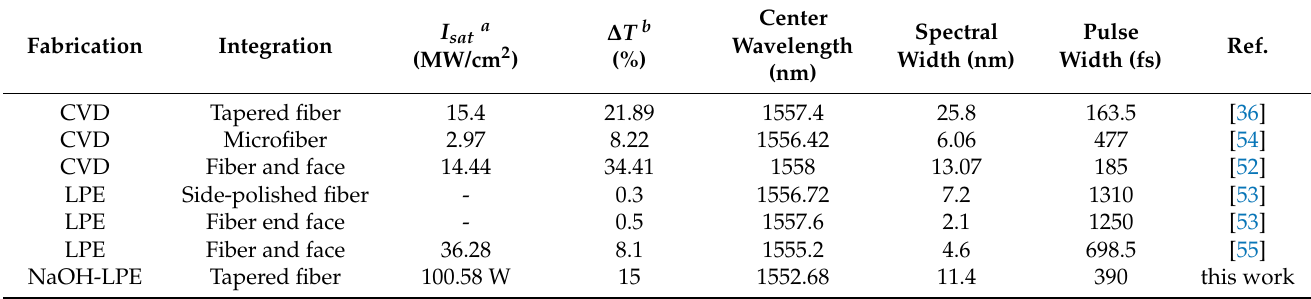
Table 1. WSe 2 as a SA for mode-locked fiber laser at 1550